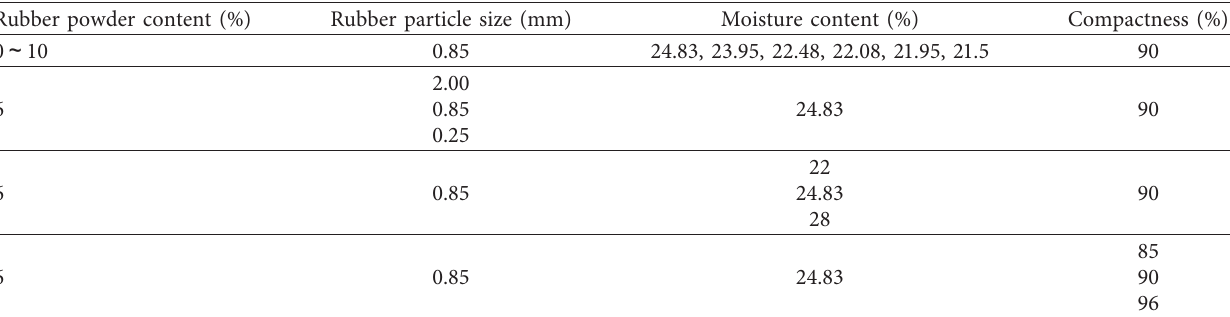
Table 3: Rubber mixed soil cooperation